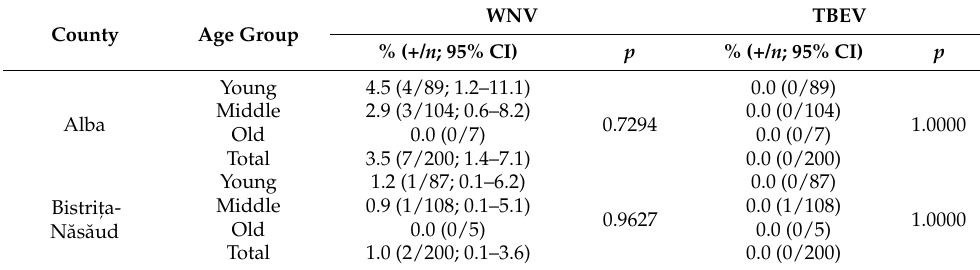
Table 5. WNV and TBEV IgG seroprevalence by SNT in each county for each age